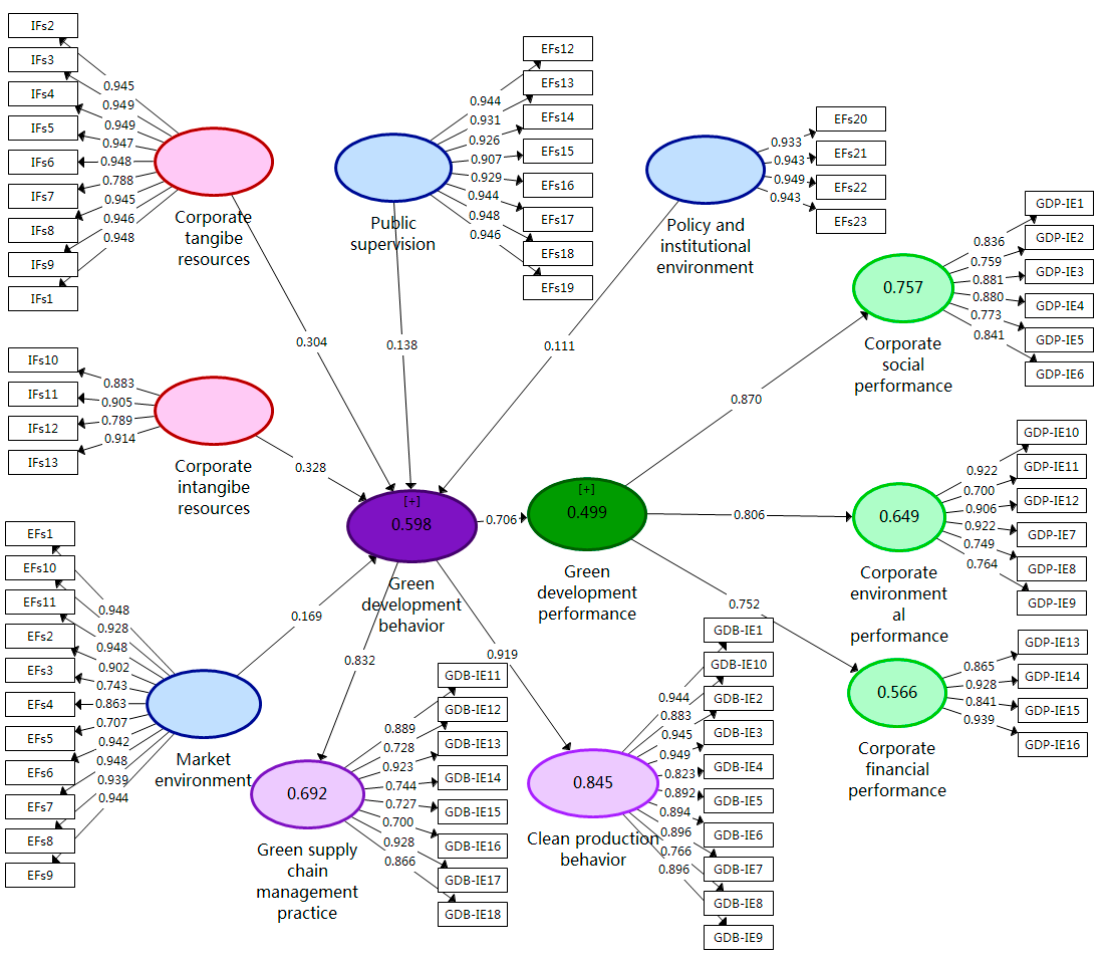
Figure 2. Tests of the measurement models. Table 5. Path coefficients and confidence interval.